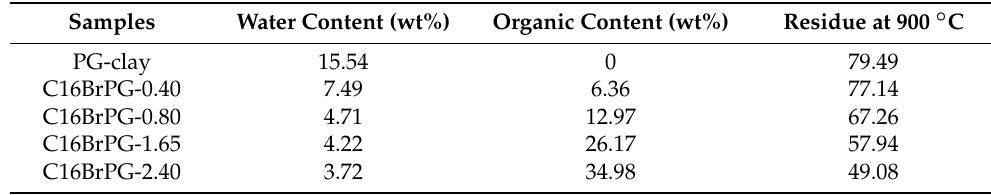
Table 7. Summarizes the mass related to water, surfactants molecules, and the residue from RT to 900 °C for samples prepared from C16TMABr solution.